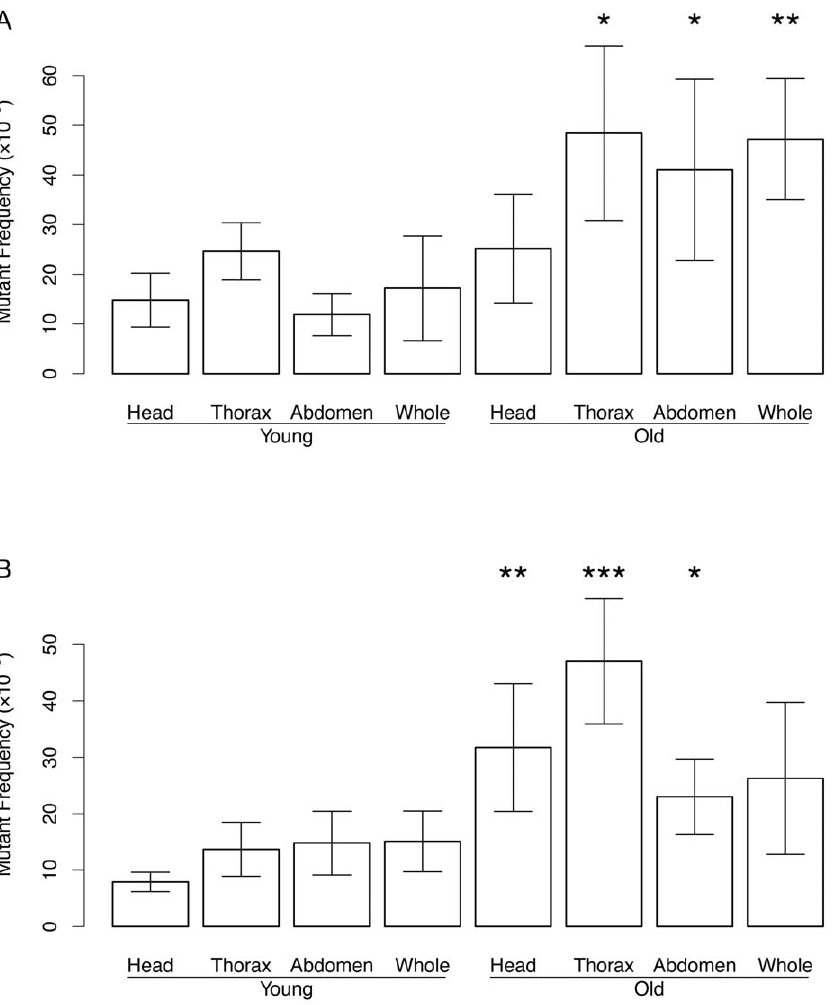
Figure 4. Mutation frequency in DNA from the head, thorax, and abdomen. Of young and old, female (A) and male (B) flies maintained at 29 u C. *p , 0.05; **p , 0.01, ***p , 1e 2 5 (t-test of old vs. young). Mutation frequency of old male thorax was significantly different from old male abdomen (p=9.13e 2 05) and old male head (p=0.01092). Mutation frequency of old female thorax was different only from old head p=0.03318. Error bars are Standard